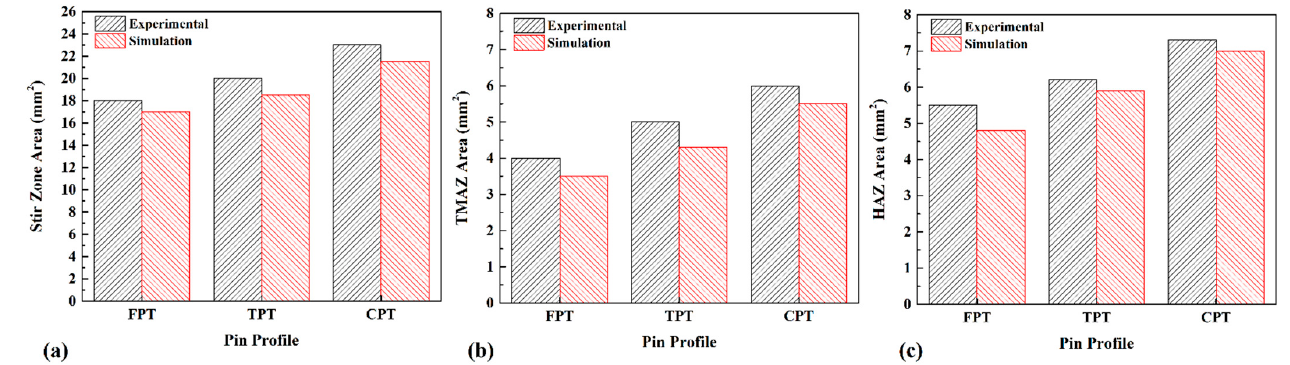
Figure 9. Comparison between dimensions of ( a ) stirred zone, ( b ) TMAZ, and ( c ) HAZ areas predicted by simulation and measured experimentally.